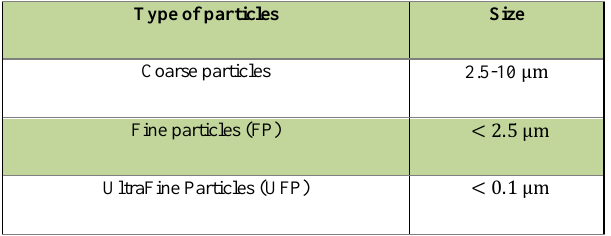
Table 1. Different types of particles based on